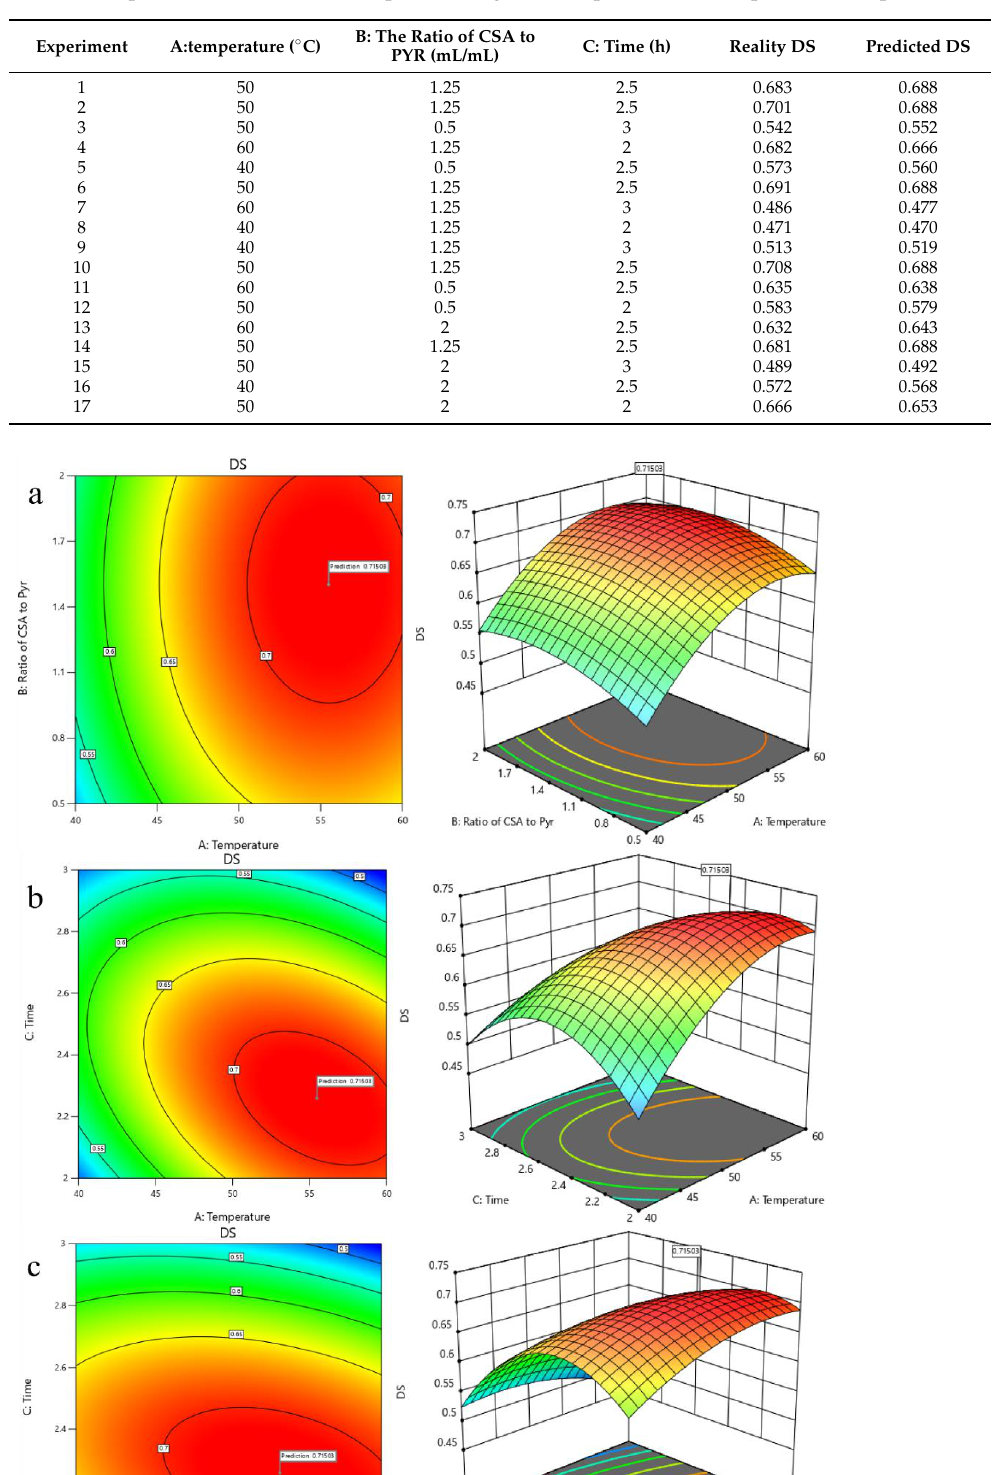
Table 2. Response surface central composite design, and experimental and predicted responses.